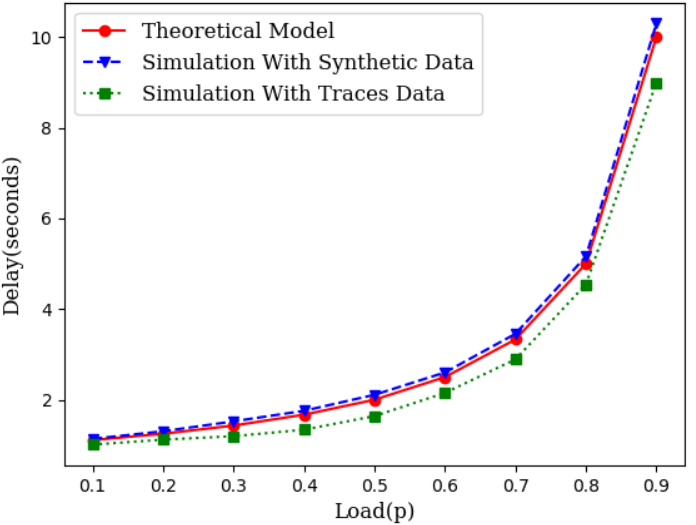
Figure 3. An illustration of closeness of the theoretical model with